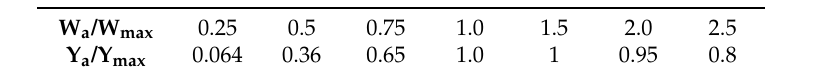
Table 3. Water-yield function parameters.